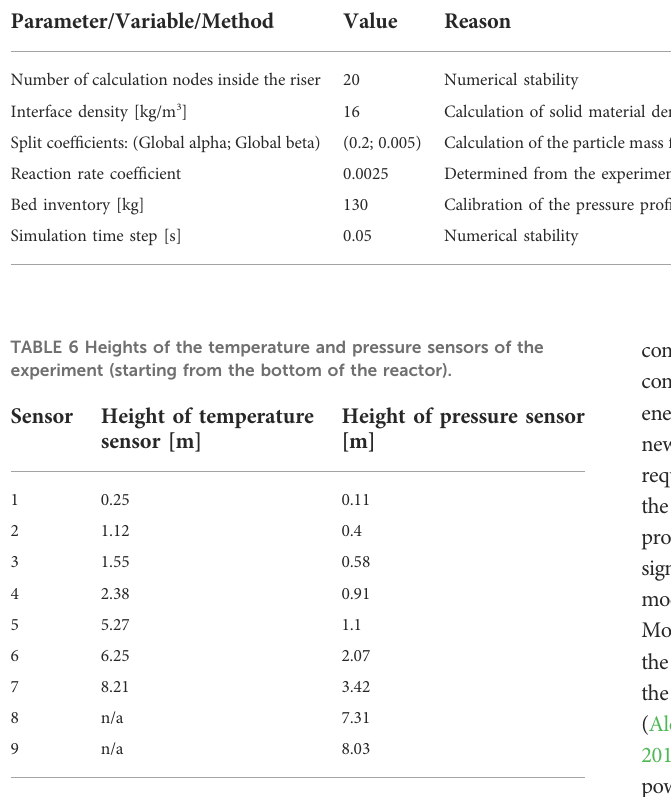
TABLE 5 Tuned parameter, variable, and method in the fl uidized bed model.